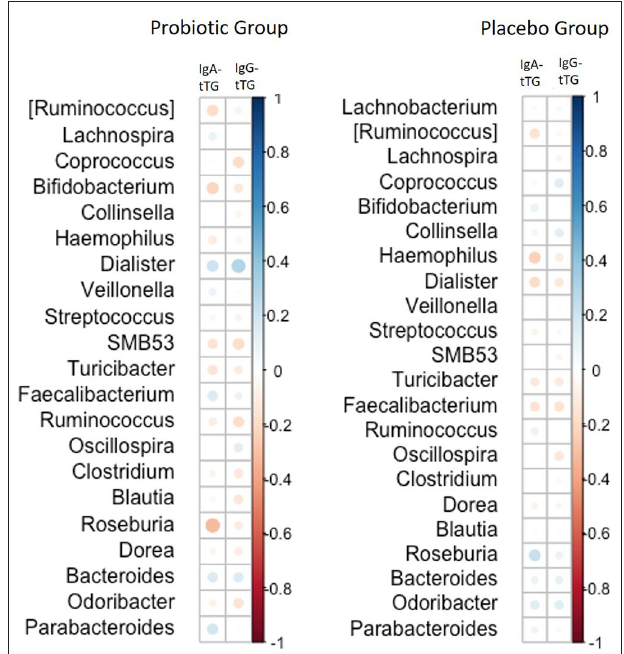
FIGURE 3 | Correlations between the amount of gut microbiota on genus level and levels of IgA-tTG and IgG-tTG in children receiving either a mixture of L. plantarum HEAL9 and L. paracasei 8700:2 (probiotic group) or maltodextrin (placebo group) . Positive correlations are marked in blue circles and inverse correlations in red circles. The size of the circles corresponds to the magnitude of Spearman’s rho correlation.